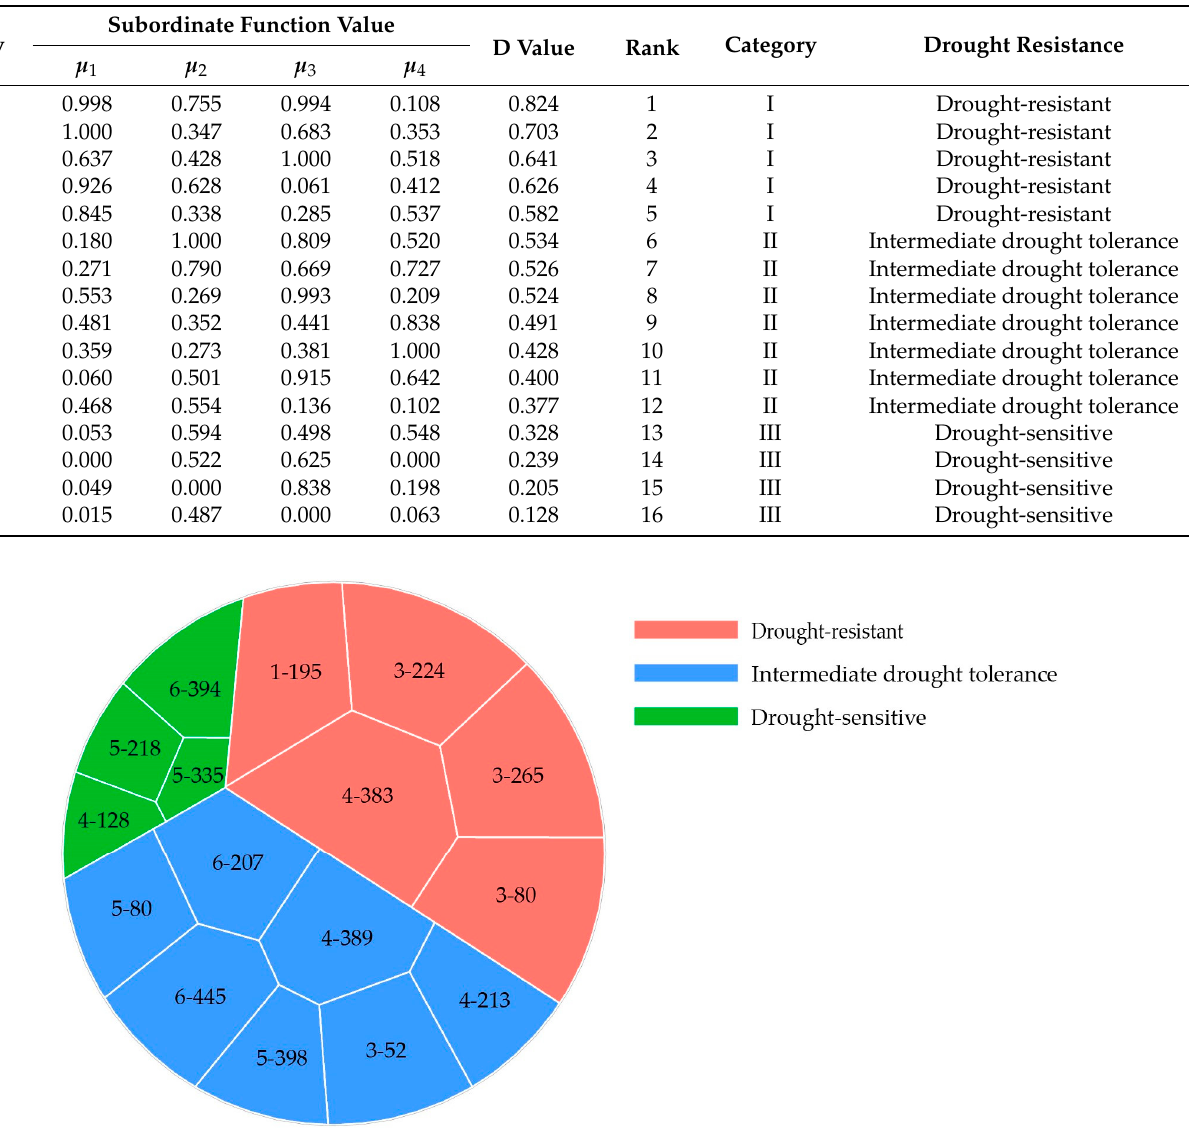
Table 6. Evaluation of drought resistance of the tested families.